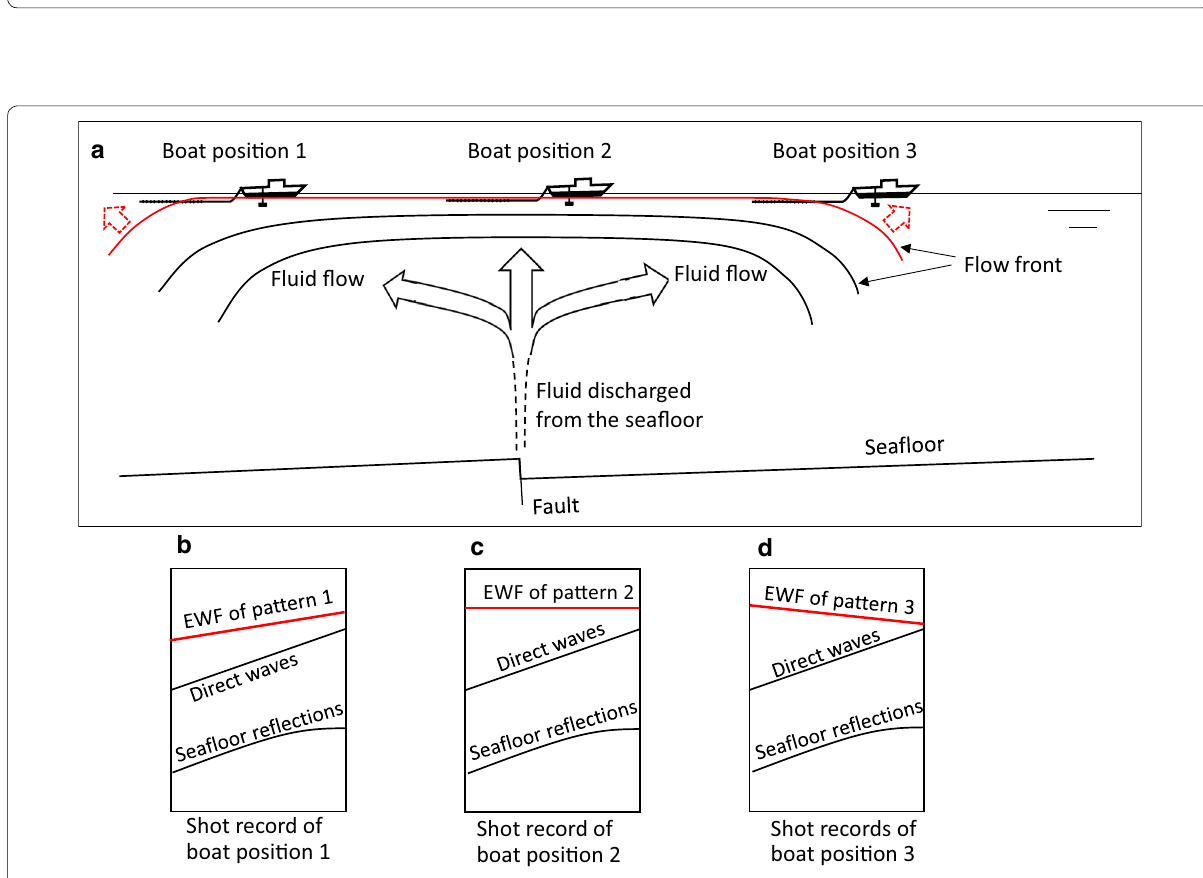
Fig. 10 The EWF observed in the shot records of line 14. The EWF on this line is less conspicuous than those of lines 10 and 16; two patterns of the EWF are, however, visible on both sides of shot point 44: EWF of pattern 1 and EWF of pattern 3. The survey boat sailed toward the west on this line